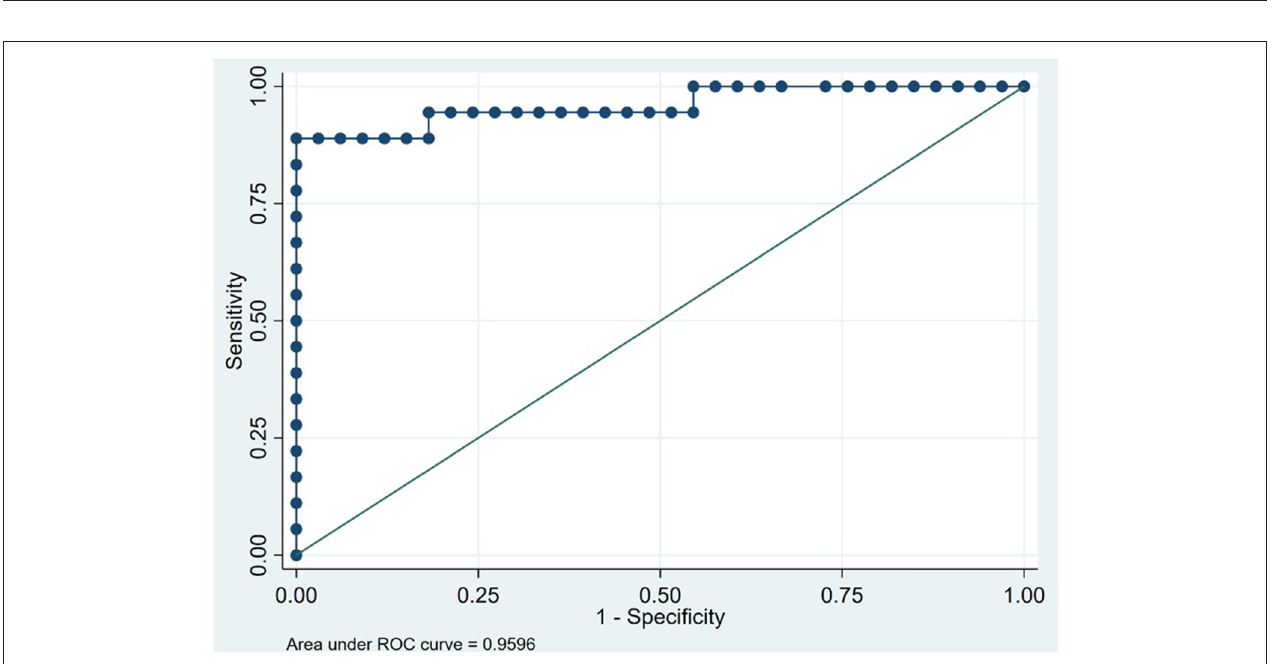
FIGURE 2 | Receiver operating characteristic curve for the Addenbrooke’s Cognitive Examination plus the INECO frontal screening plus Mini-social Cognition and Emotional Assessment in 51 patients to discriminate between behavioral variant frontotemporal dementia and Alzheimer’s disease (Instituto Peruano de Neurociencias, Lima, Peru;